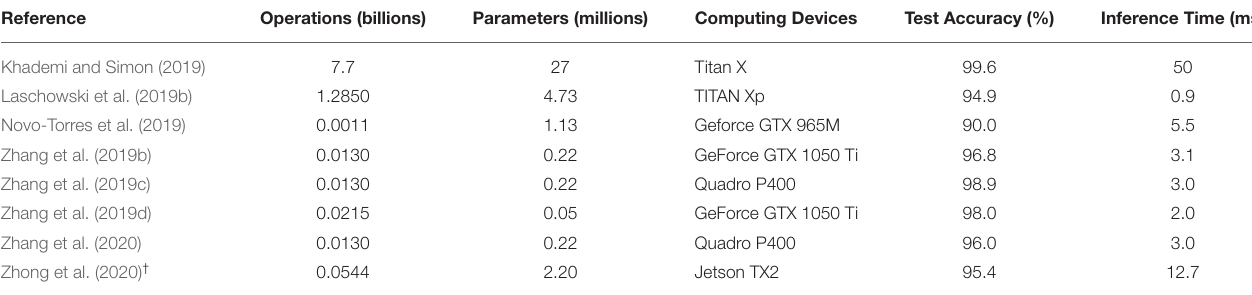
TABLE 3 | Previous environment recognition systems that used convolutional neural networks for image classification of walking